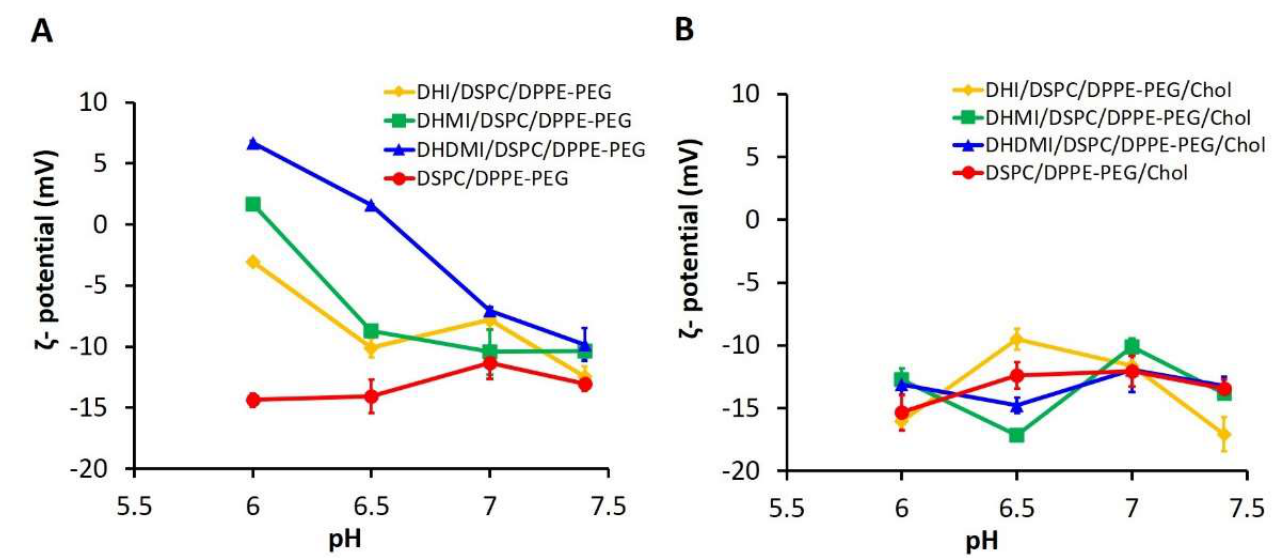
Figure 4. pH-triggered acquisition of positive surface charges by ICL. ζ-potential of ICL without ( A ) or with ( B ) 25% cholesterol were measured at 37 °C, pH 6.0, 6.5, 7.0, and 7.4. Data are presented as mean ± SD, N = 3.